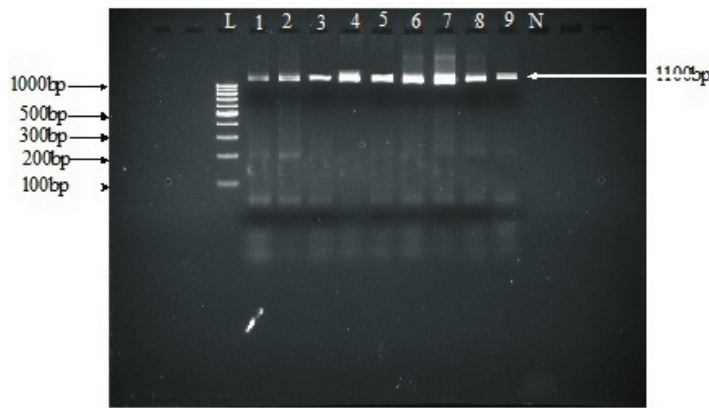
Figure-1. 2% Agarose gel electrophoresis of allele specific FecB PCR product. Lane;